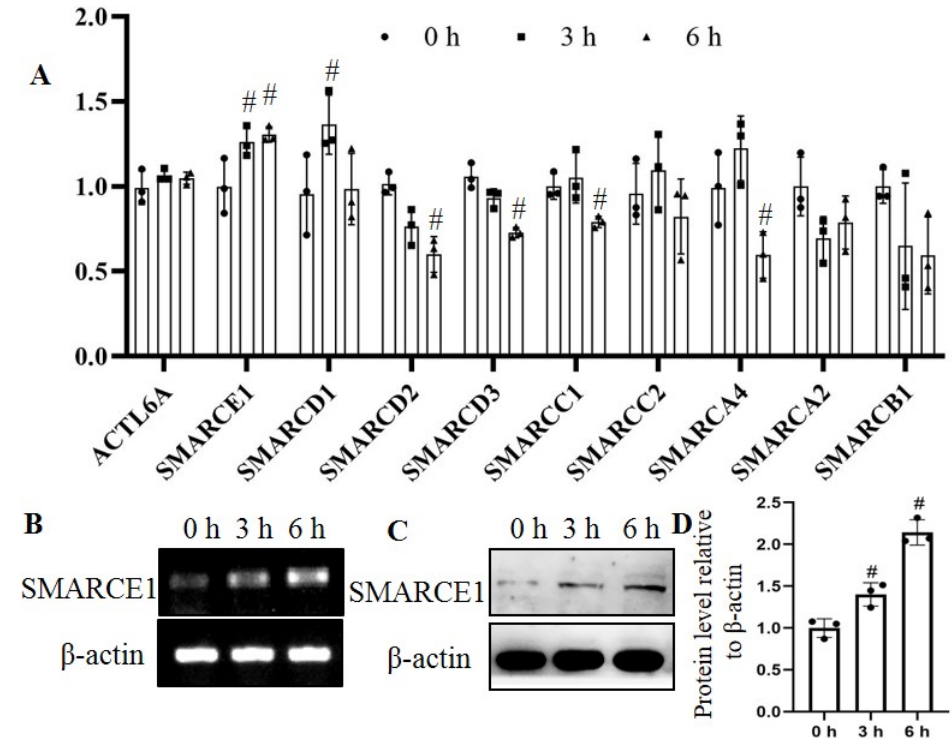
Figure 1. The mechanical strain affected the expression of SWI/SNF complex subunits. ( A ). Mc3t3-E1 cells were cyclic-stressed for 3 and 6 h, and RT-qPCR was used to examine the levels of SWI/SNF complex subunits. The expression of SMARCE1 was tested by reverse transcription semi-quantitative PCR ( B ) and Western blotting ( C ) in respond to mechanical stimulation at 3 and 6 h. ( D ) The protein levels of SMARCE1 showed in C were quantified by Image J software. The data represent three sets of independent experiments ( n = 3) and were shown as means ±SD. # p < 0.05 vs. the 0 h group. Genes 2020 , 11 , x FOR PEER REVIEW